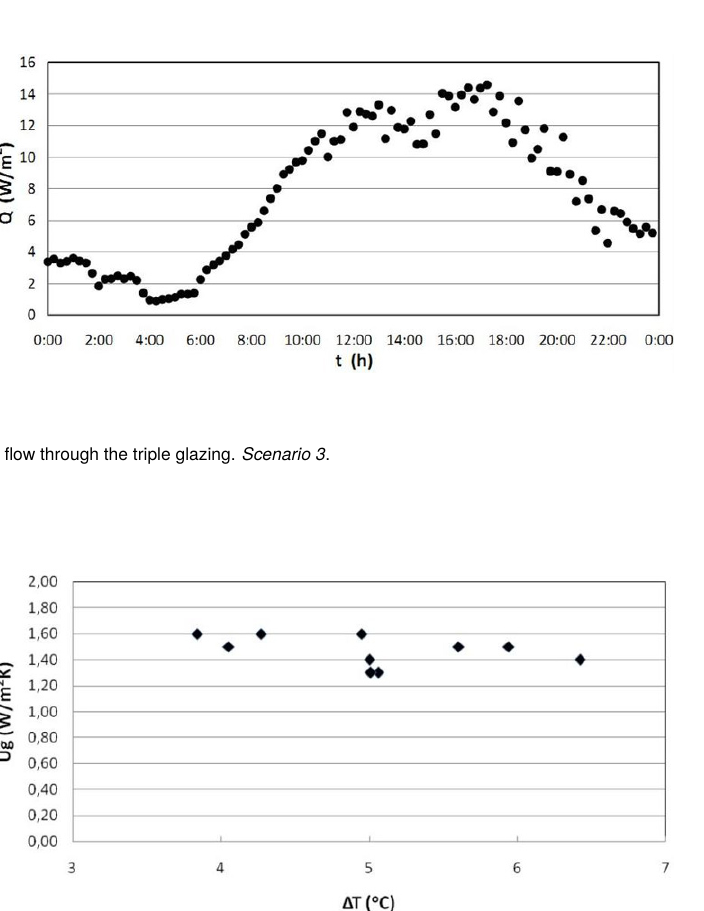
Figure 17. Variation of U g versus temperature difference ∆Îď . Scenario 3 .